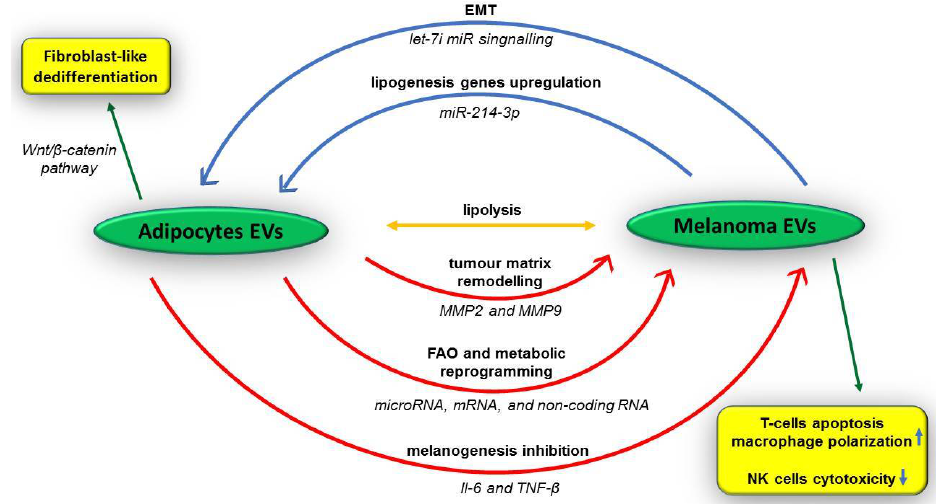
Figure 2. Adipocytes and melanoma cells EVs ”dialogue” in tumour microenvironment. Adipocytes and melanoma cells secrete EVs, which promote tumour progression and metastasis by tumour matrix remodelling, melanogenesis inhibition, fatty acid oxidation (FAO), and metabolic reprogramming into melanoma cells, along with epithelial-mesenchymal transition (EMT) induction, lipolysis, and lipogenesis genes upregulation in fat cells. EVs—extracellular vesicles; EMT—epithelial-mesenchymal transition; FAO—fatty acid oxidation; IL-6—interleukin 6; miRNA—microRNA; MMP—matrix metalloproteinase; NK cells—natural killer cells; T-cells—T lymphocytes; TNF-β—tumour necrosis factor β; ↑ —increased level; ↓ —decreased level.